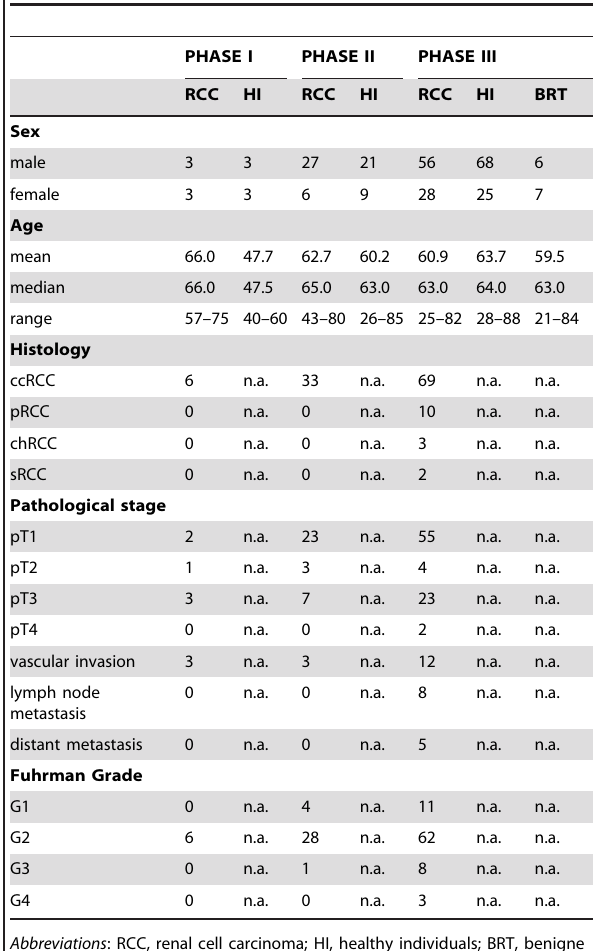
Table 1. Clinical-pathological